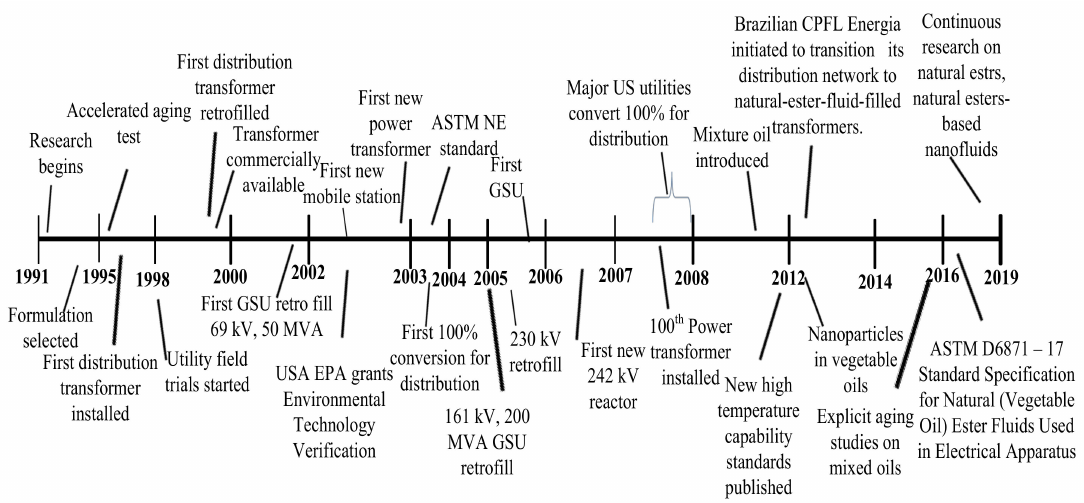
Figure 4. Timeline of proceedings in the development and application of natural-ester insulating